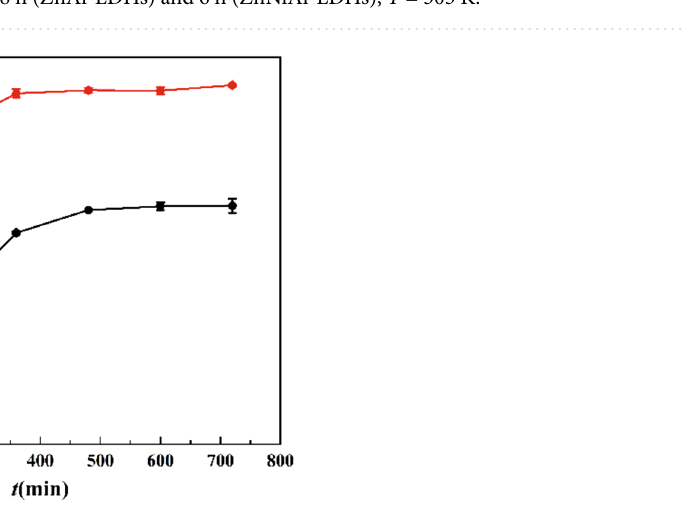
Figure 4. Effect of pH on the adsorption of U(VI) by ZnAl-LDHs and ZnNiAl-LDHs ( a ), Zeta potential of ZnNiAl-LDHs ( b ) and the distribution of U(VI) species in aqueous solution as a function of pH ( c ) ( C 0 (U) = 35